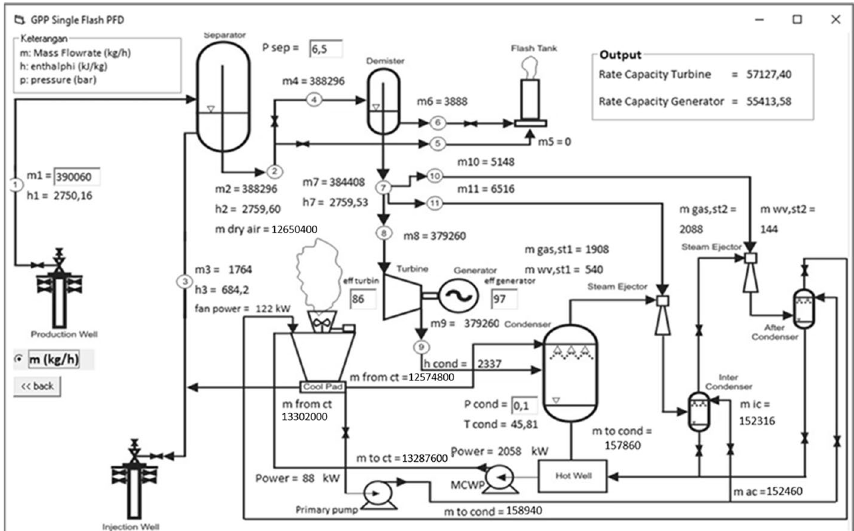
Fig. 16 Screen results Kamojang Units 2 and 3 types of